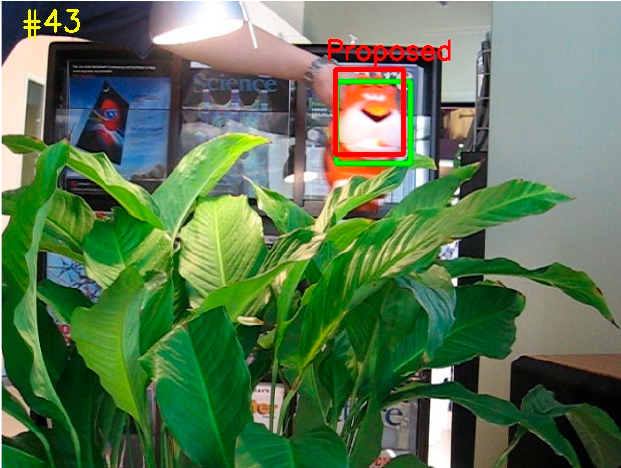
Figure 16. Frame Comprising the MB, IV, and FM Attributes.